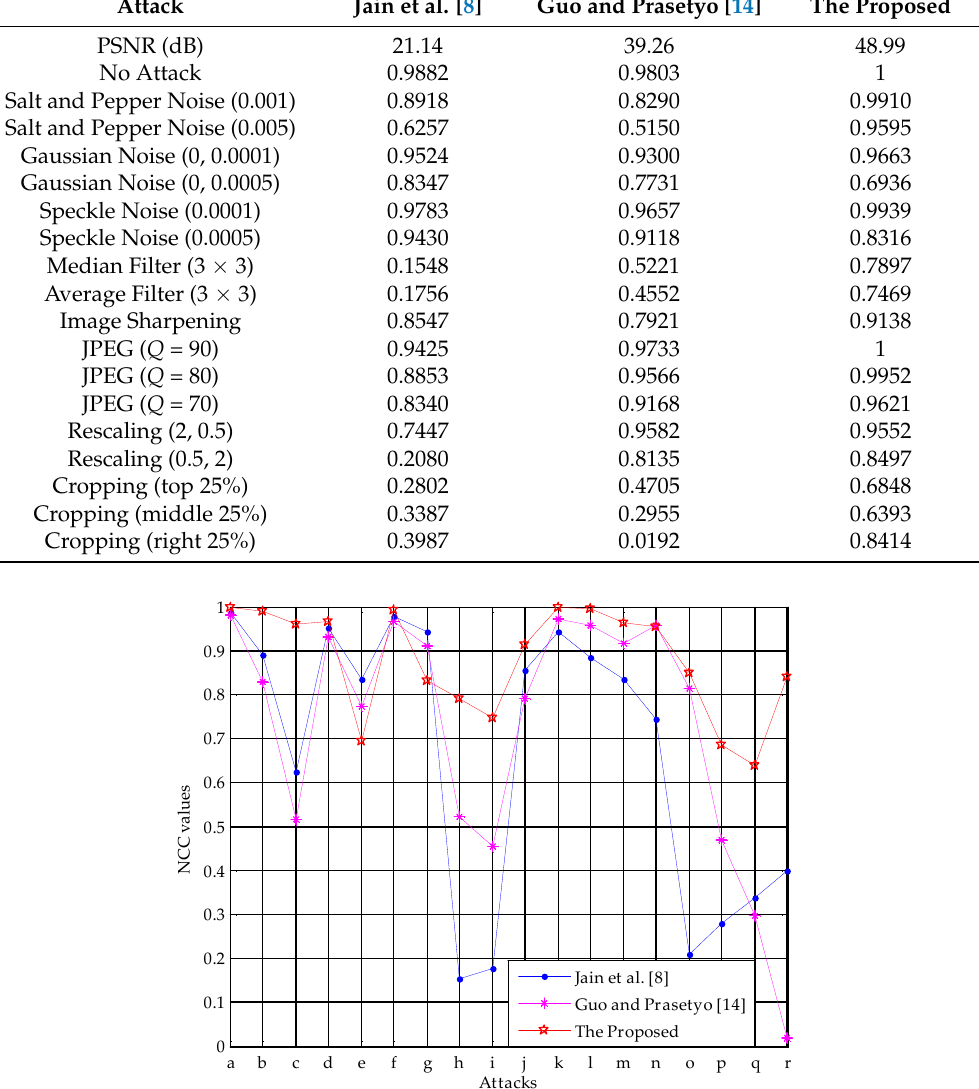
Table 5. Computational time comparisons between the proposed watermarking scheme and other singular value decomposition (SVD) domain watermarking schemes. Computational Time (s)